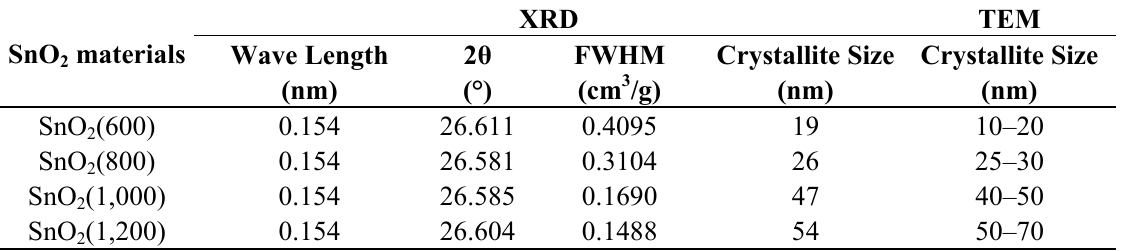
Table 1. Crystallite sizes calculated using XRD and TEM